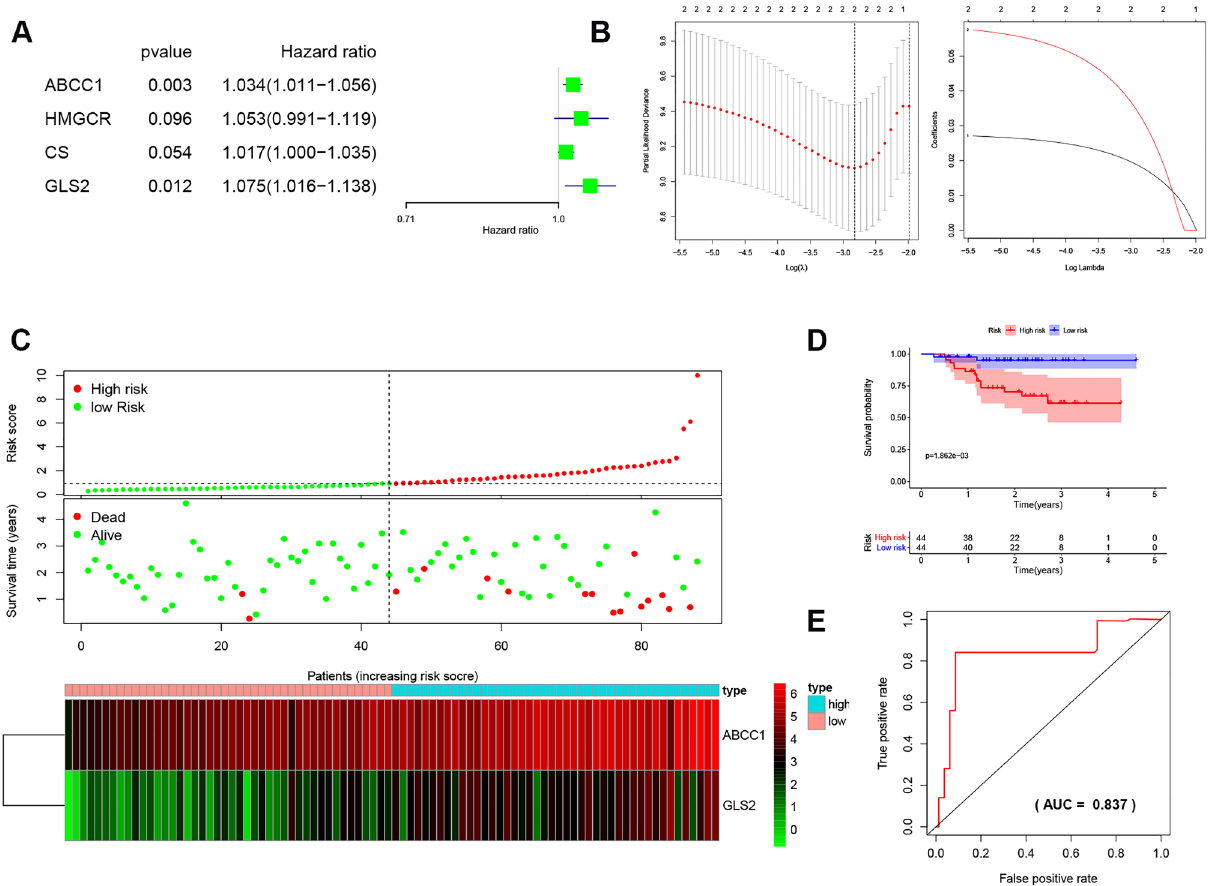
Figure 4. Risk model from three FRGs. ( A ) Univariate Cox analysis between four FRGs and poor progression- free survival of NPC using the R package “ConsensusClusterPlus”. ( B ) LASSO calculated the risk model using the R package “glmnet” (https:// cran.r- proje ct. org/ src/ contr ib/ Archi ve/ glmnet/). ( C ) The distributions from two prognostic FRGs. ( D ) Kaplan–Meier poor progression-free survival curves for patients in risk score. ( E ) ROC curve showed the efficiency of the risk score model using the R package